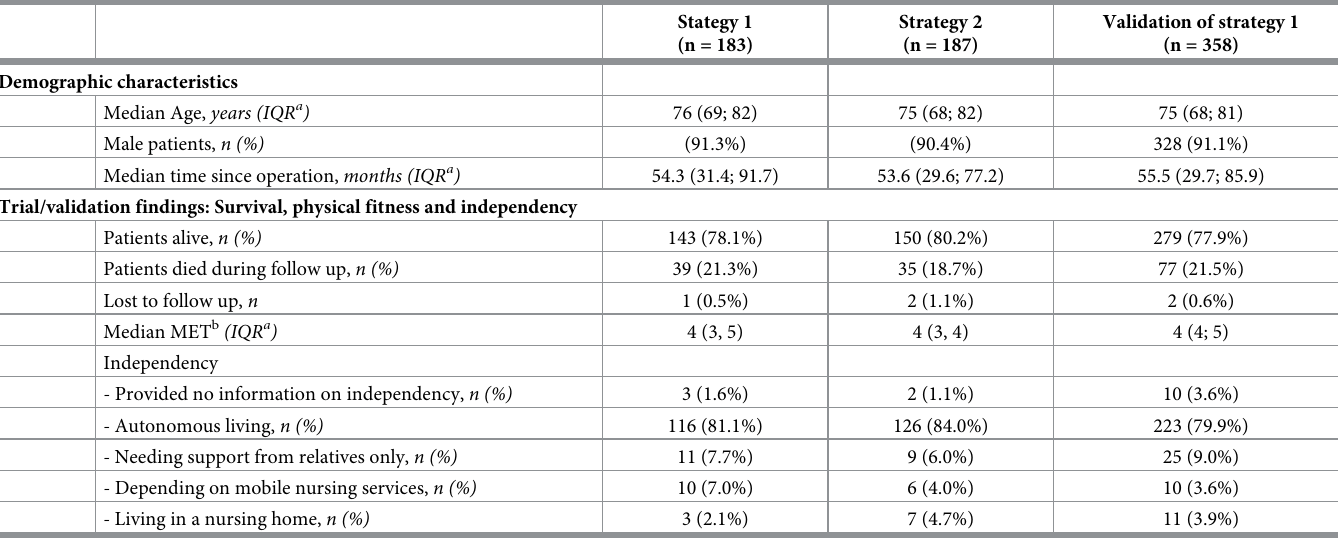
Table 1. Baseline characteristics as well as trial and validation